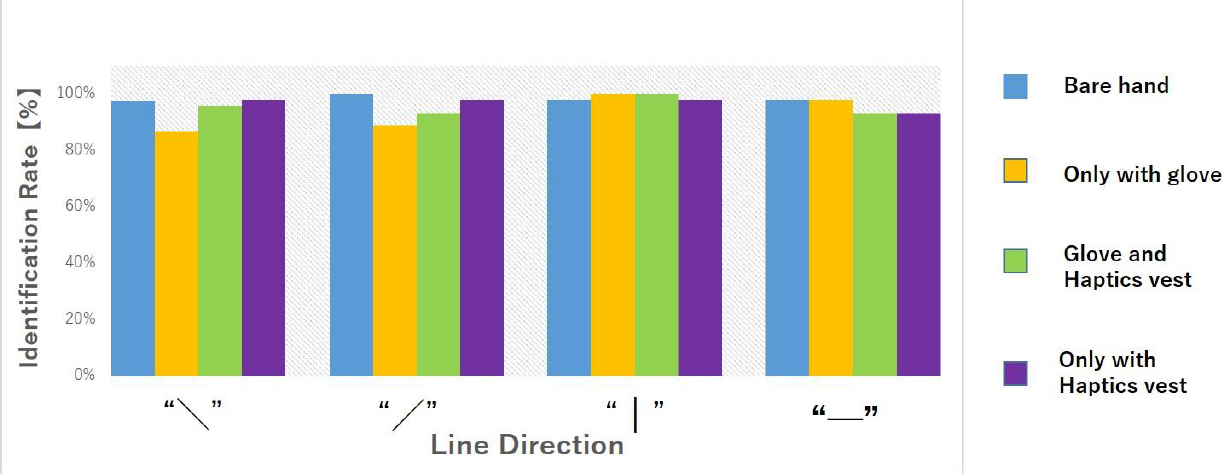
Figure 10. Results of experiment 1 Figure 11. Identification rate of object shape under each scenario.